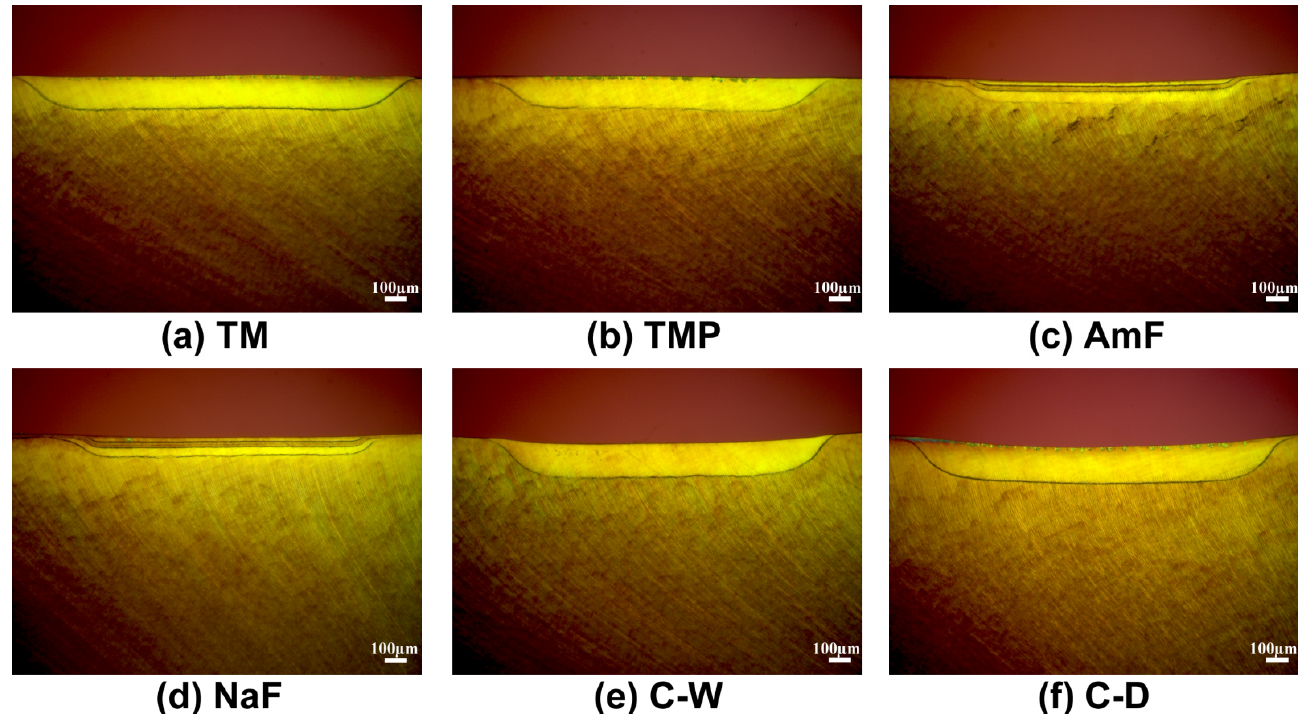
Figure 6. Polarized light images of dentin lesions showing different lesion depths caused by the protective influence of treatment with different toothpaste slurries (a-d) during artificial demineralization compared to controls (e,f).